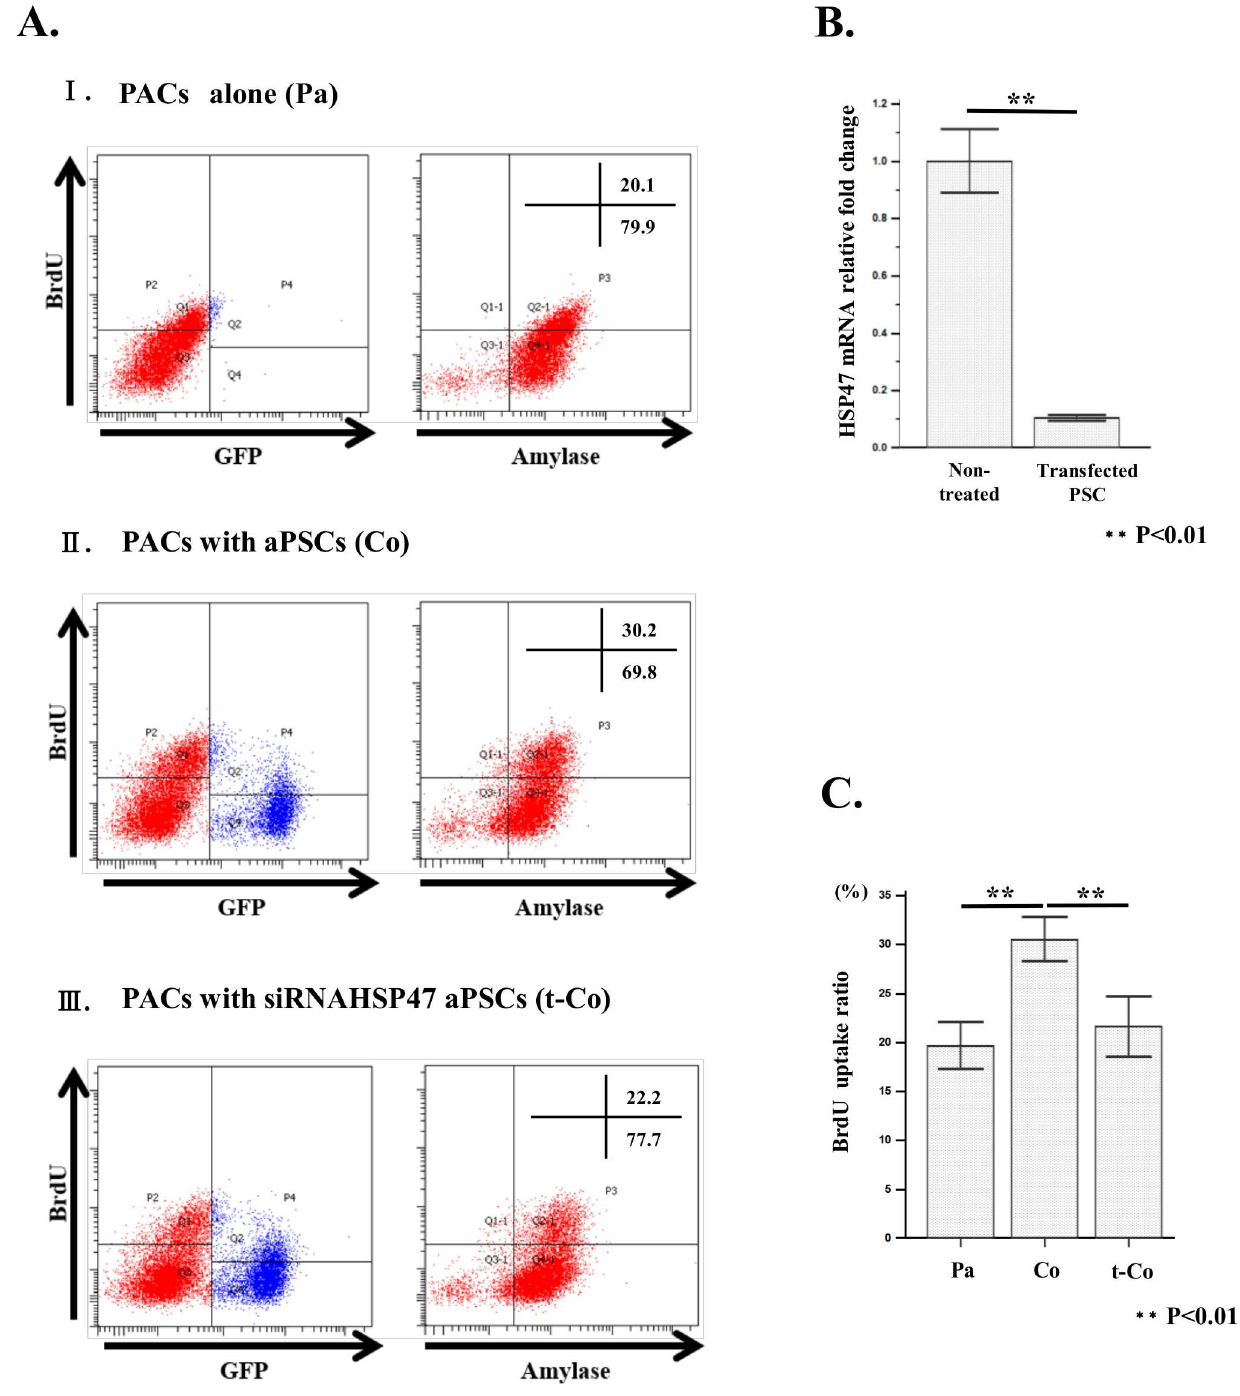
Fig 11. Effect of siRNA HSP47 on stimulatory activity of aPSCs to BrdU uptake by PACs in co-culture system. (A) Ⅰ BrdU uptake by PACs was analyzedby flow cytometry for GFP fluorescence, and expressionof BrdU and amylase using each corresponding antibody.(A) Ⅱ BrdU uptake by PACs co-culturedwith PSCs isolated from GFP rat was analyzedby flow cytometry for GFP fluorescence, and expressionof BrdU and amylase using each corresponding antibody.(A) Ⅲ BrdU uptake by PACs co-cultured with siRNAHSP47transfected PSCs from GFP rat was analyzedby flow cytometry for GFP fluorescence, and expressionof BrdU and amylase using each corresponding antibody.(B) Histogram of HSP47 mRNA expressionlevels of siRNA HSP47 transfected and non-treatedPSCs from GFP rat. Experiment was carried out three times and averagevalue of the HSP47 mRNA levels in PSCs as measuredby qPCR was calculated. Values were normalized to that of non-transfected PSCs. Note that almost completeknock down of HSP47 mRNA by siRNA HSP47. (C) Histogram of Mean